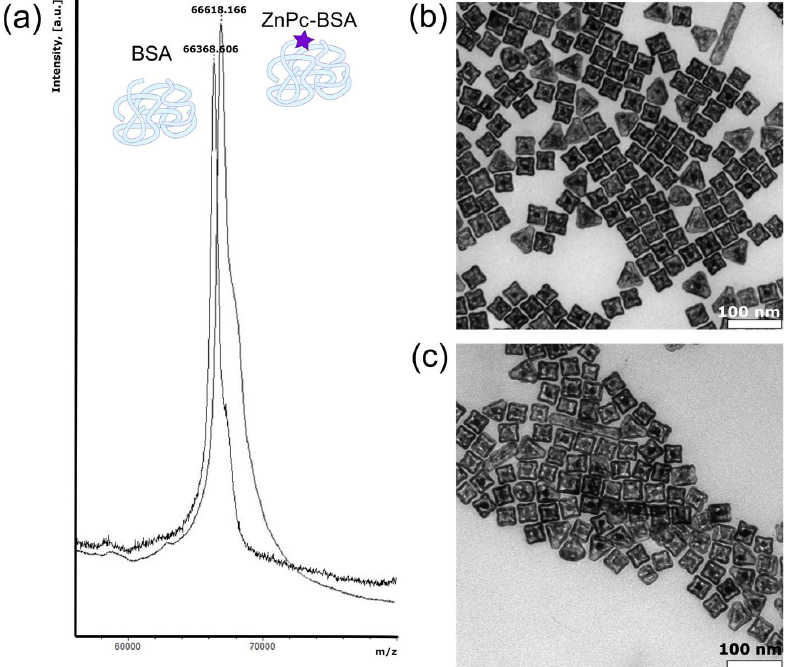
Figure 1. ( a ) Mass spectrometry measurement for BSA aqueous solution and an aqueous solution of ZnPc-BSA conjugate; ( b ) TEM image of gold nanocages (AuNCs); ( c ) TEM image of BSA-coated gold nanocages (AuNC-BSA).